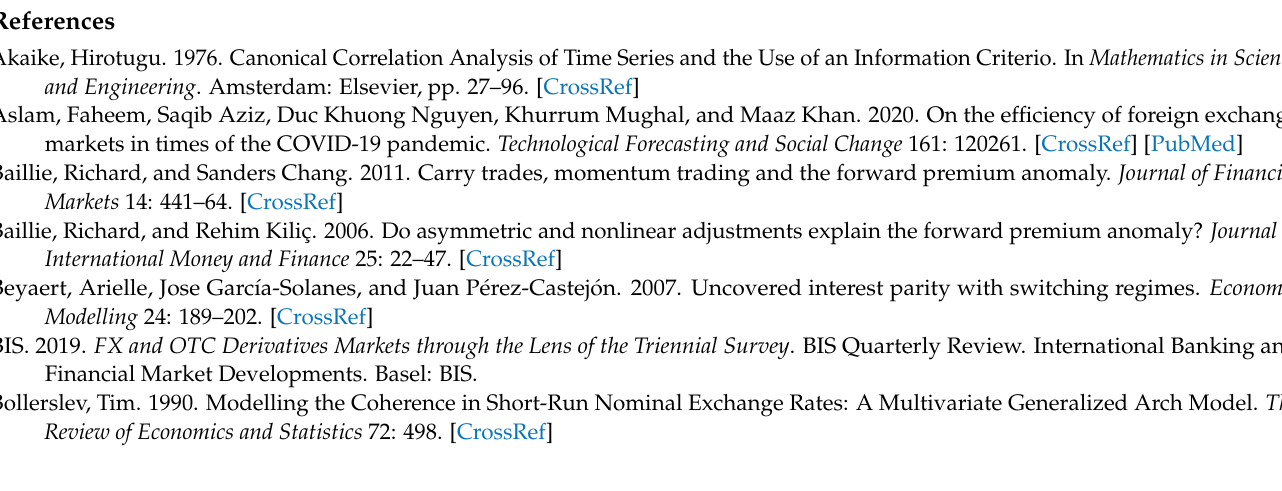
Figure A2. BDS test results (for various embedding dimension: from m = 2 (bottom yellow line) to m = 9 (upper red line)).